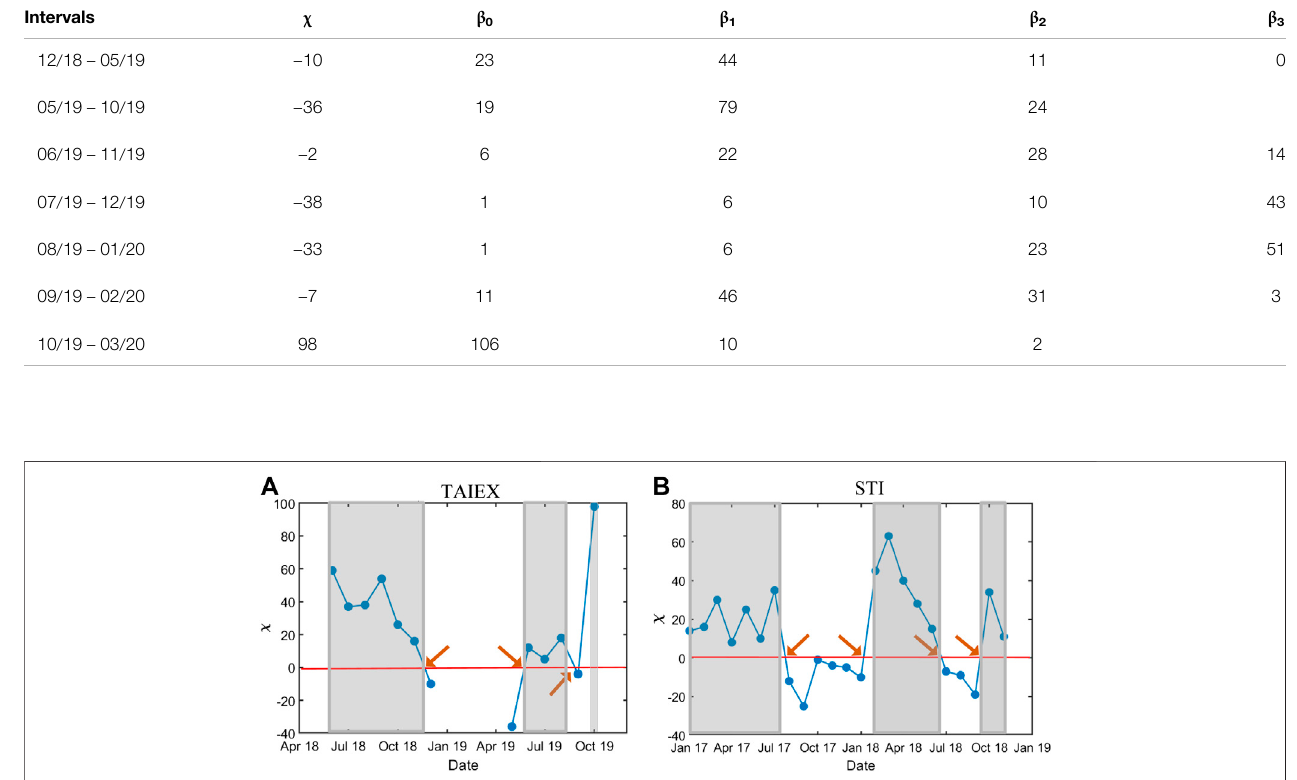
FIGURE 14 | The Euler characteristic χ in (A) TAIEX and (B) STI against dates. Each date represents a six-month period in which the correlation matrix was constructed. Besides, different dates are associated with different values of ϵ . The gray bands are over the same periods shown in Figure 11 and cover Euler characteristics that are